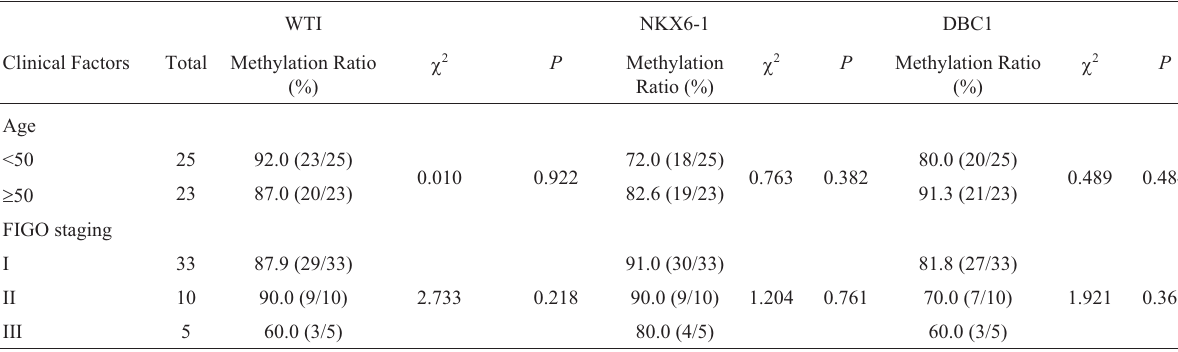
Table 6 - Correlation of promoter region methylation with clinical factors of cervical cancer